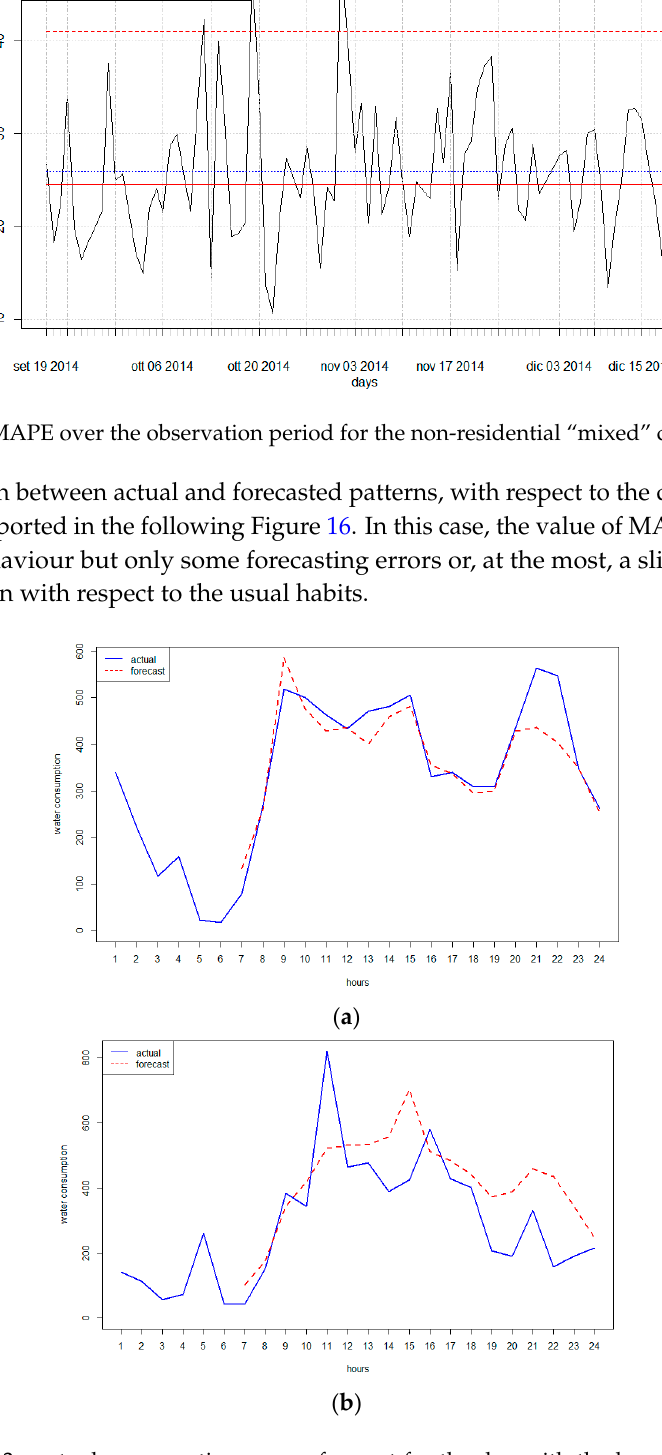
Figure 16. Case 3—actual consumption versus forecast for the day with the lowest ( a ) and highest ( b ) MAPE.